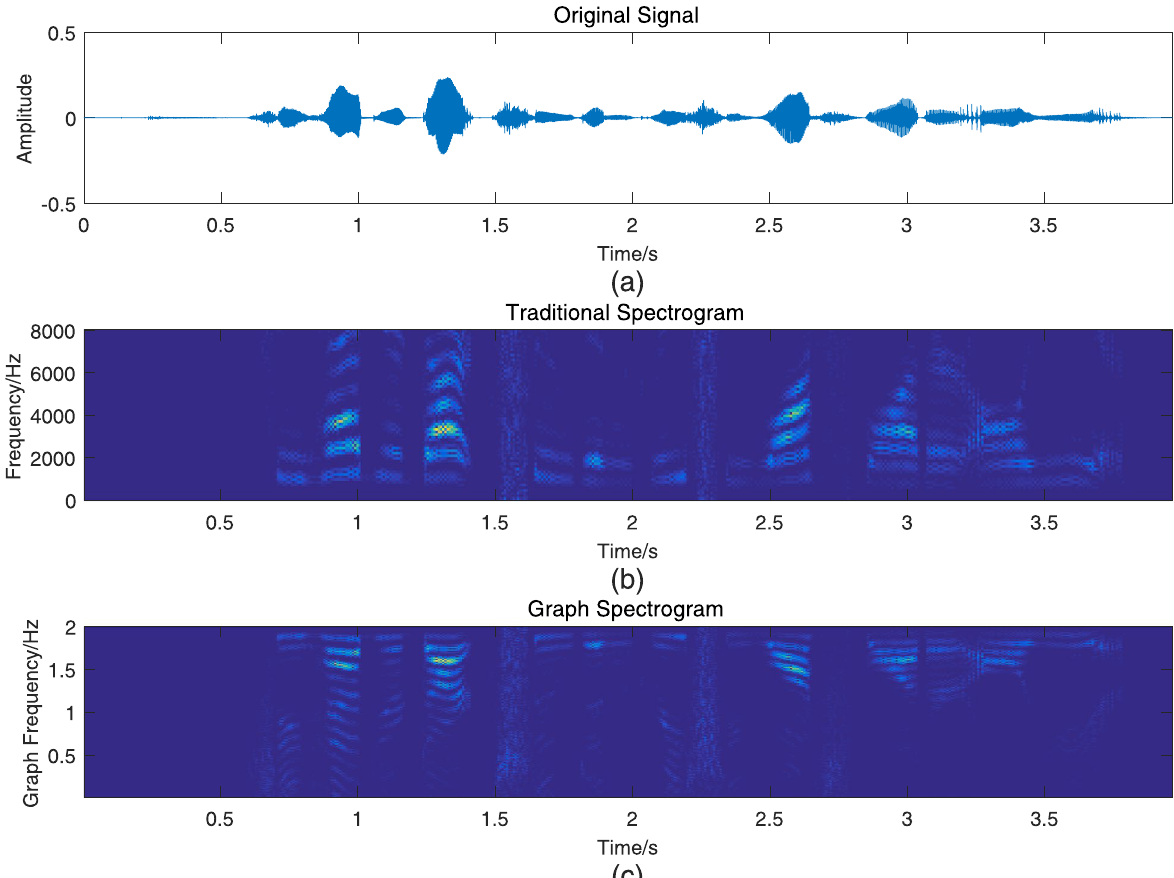
Fig. 2 Clean speech signals and its spectrograms. a The clean speech signals. b The traditional spectrogram. c The graph